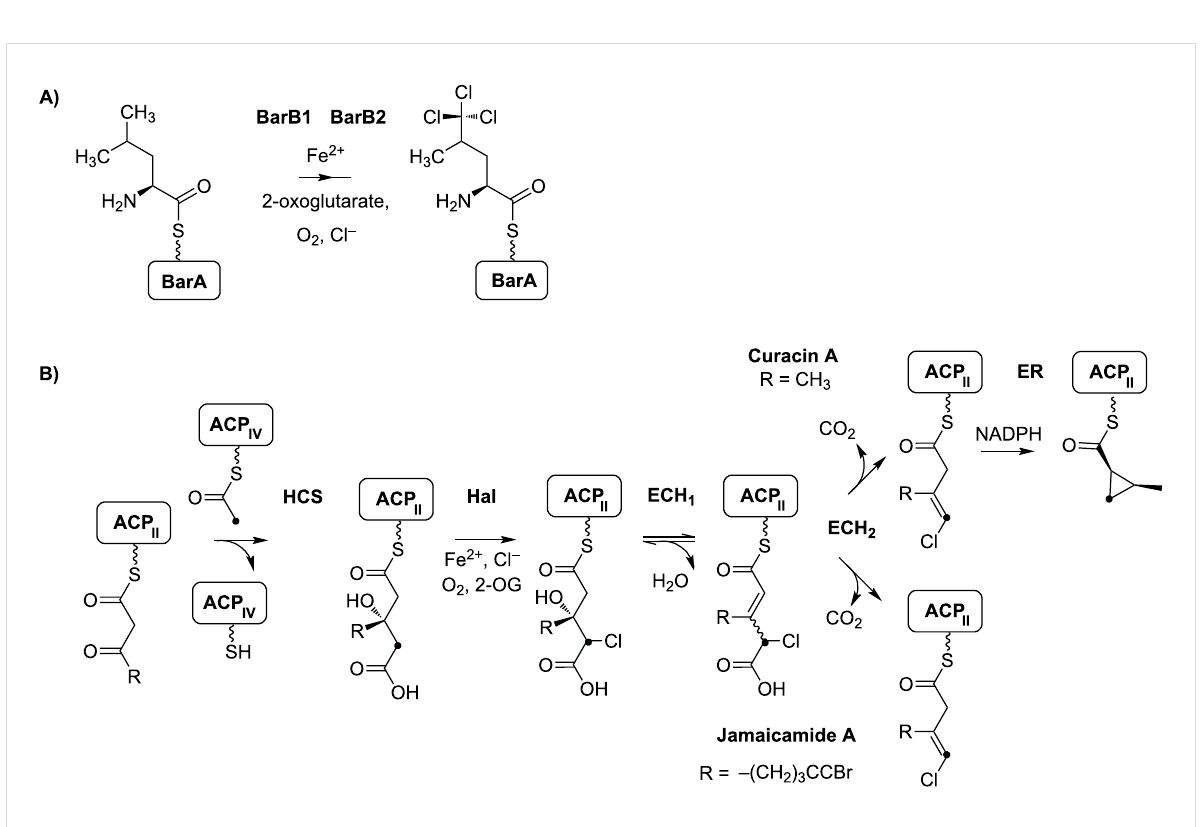
Figure 6: A) Formation of the trichloroleucyl starter unit of barbamide ( 7 ) synthesis through the non-heme iron(II)-dependent halogenases BarB1 and BarB2. B) Formation of cyclopropane and vinyl chloride functional groups in curacin A ( 9 ) and jamaicamide A ( 8 ) biosynthesis, respectively. The halo- genated carbon is highlighted with a black dot. ACP: Acyl carrier protein; HCS: HMG-CoA synthase-like enzyme; Hal: Halogenase; ECH 1 : Dehy- dratase; ECH 2 : Decarboxylase; ER: Enoyl